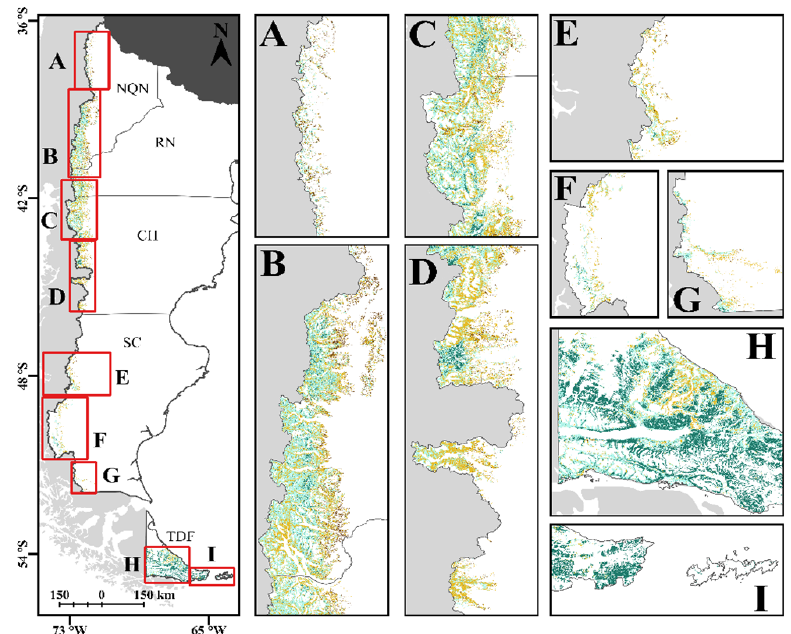
Figure 6. Predicted relative RMSE (%) maps for the modeling of soil organic carbon content (SOC)